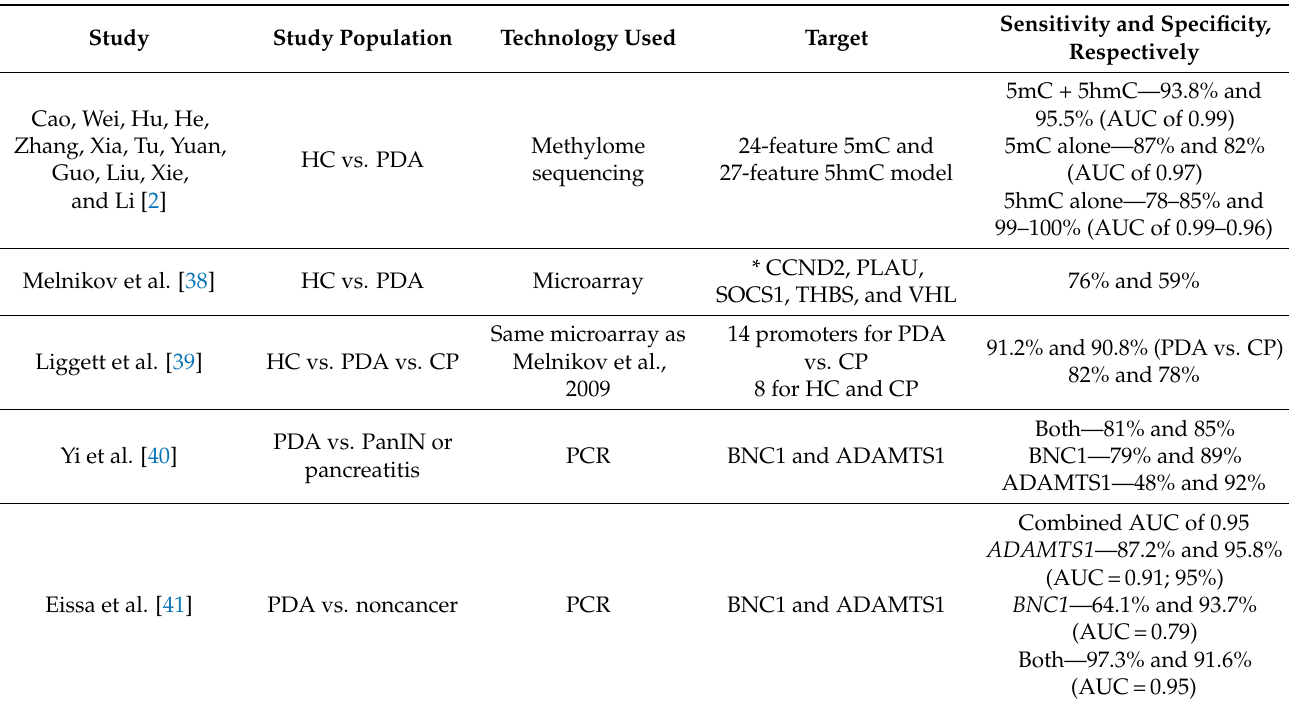
Table 1. cfDNA methylation marker studies to diagnose pancreatic ductal